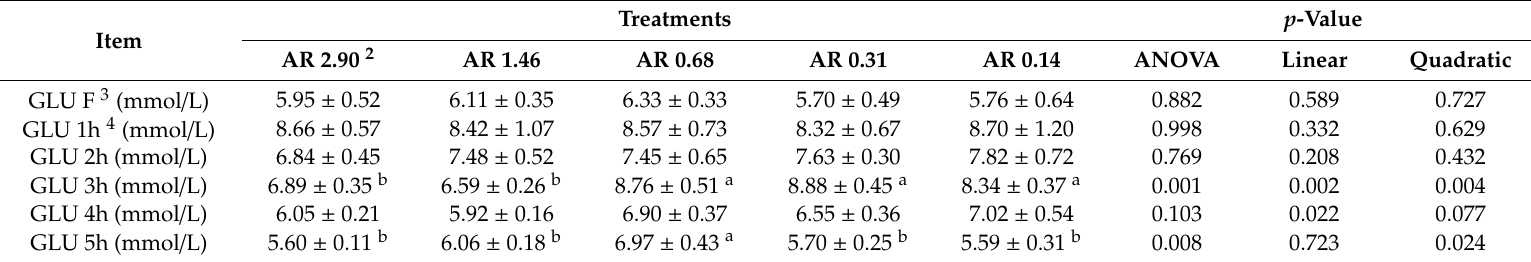
Table 5. E ff ects of dietary starch structure on serum glucose in weaned piglets (mean values with their standard errors) 1 .